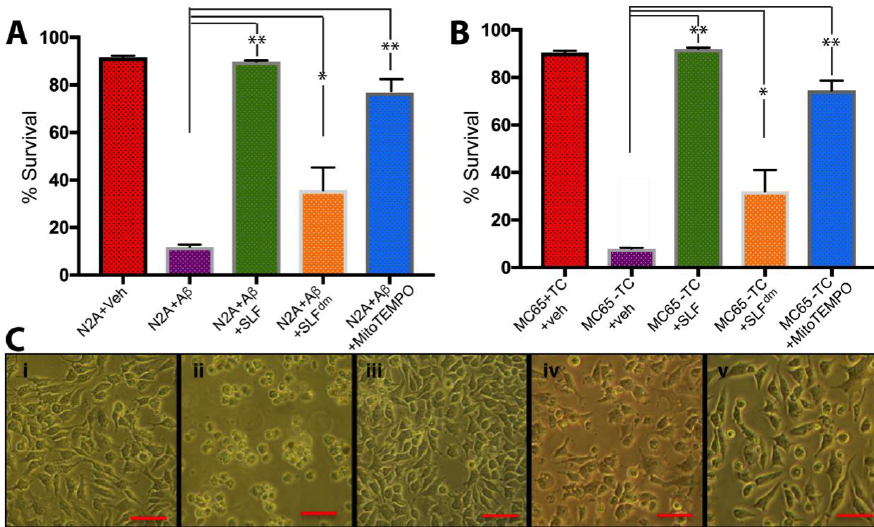
Figure 2. Protection against Aβ toxicity by SLF compared to agents bearing only an antioxidant or anti-amyloid activity. Neuronal viability by the MTT assay was determined for exogenous Aβ (N2a cells) and endogenous Aβ (MC65 cells) after 72 hours. ( A ) 1 μM exogenous Aβ was added to cultured N2a neurons and cell viability was compared to the +Aβ group. The effect of 2 μM SLF, SLF dm , and MitoTEMPO co-addition on the survival of AβO-treated N2a cells is given by the green, orange, and blue bars, respectively. The ability of SLF and its independent functionalities to protect against Aβ toxicity in MC65 neurons containing Tet-Off inducible gene expression for the Aβ precursor (APP) is shown in ( B ). The viability of the non-induced (+TC) cells is given by the red bar. The effect of 2 μM SLF, SLF dm and MitoTEMPO addition to the APP-induced (−TC) cell survival is given by the green, orange, and blue bars, respectively, and is compared to the −TC group. For both ( A ) and ( B ), compounds were added upon APP induction and cell survival was measured 72 hours later. Statistical analyses of cell counts by one-way ANOVA gives * p < 0.01, ** p < 0.001, n = 9. Error bars represent the standard error as described in the Methods section. Panel ( C ) shows light microscopy images of MC65 cell cultures three days without APP induction ( i ), with APP induction ( ii ), with APP induction in the presence of 2 μM SLF ( iii ), with APP induction in the presence of 2 μM SLF dm (iv), and with APP induction in the presence of 2 μM MitoTEMPO ( v ).